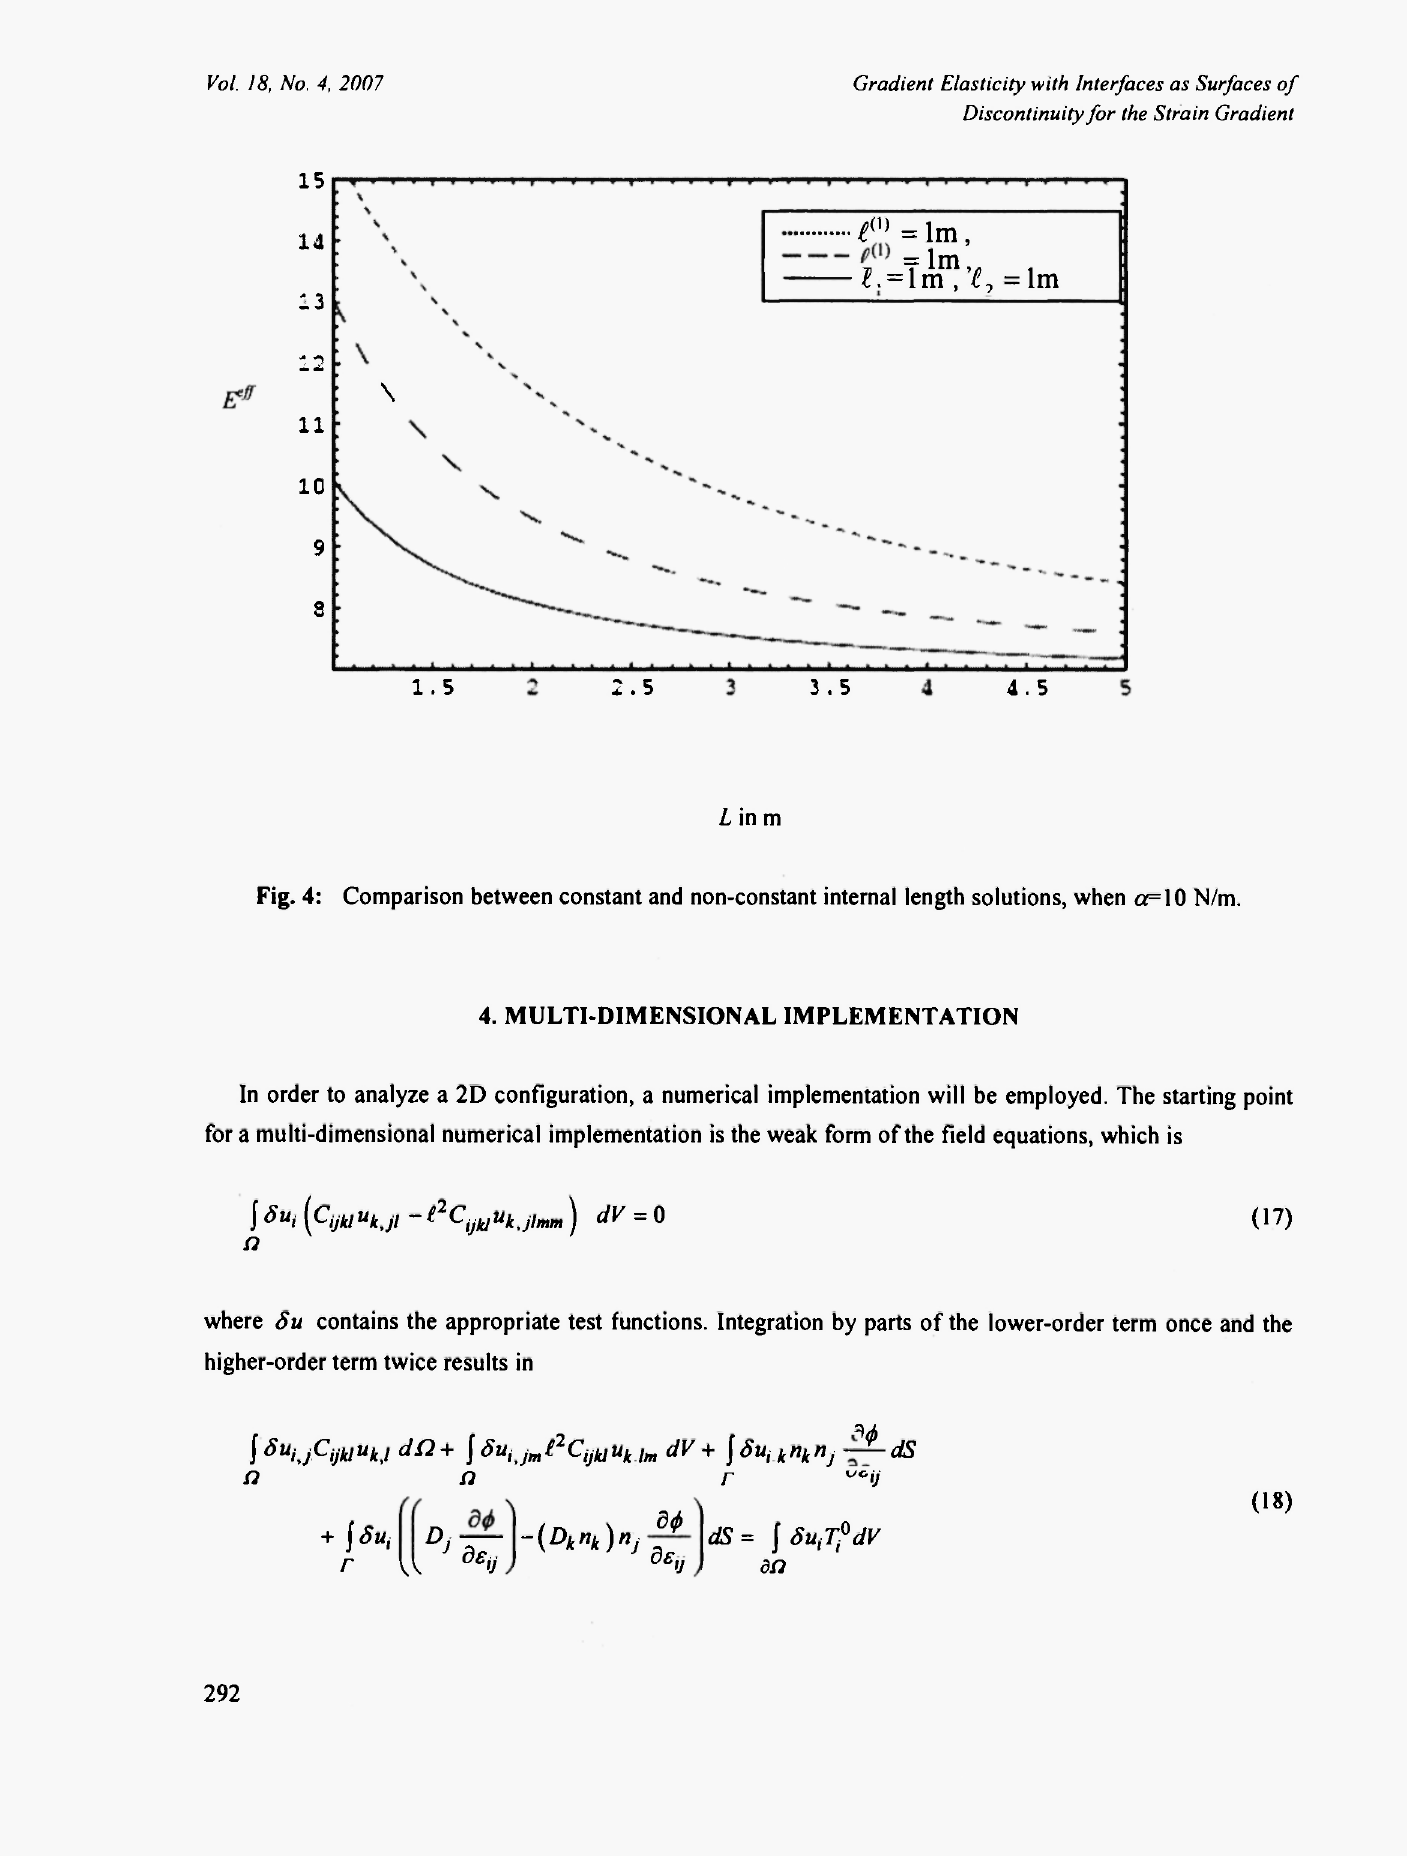
Fig. 4: Comparison between constant and non-constant internal length solutions, when a=10